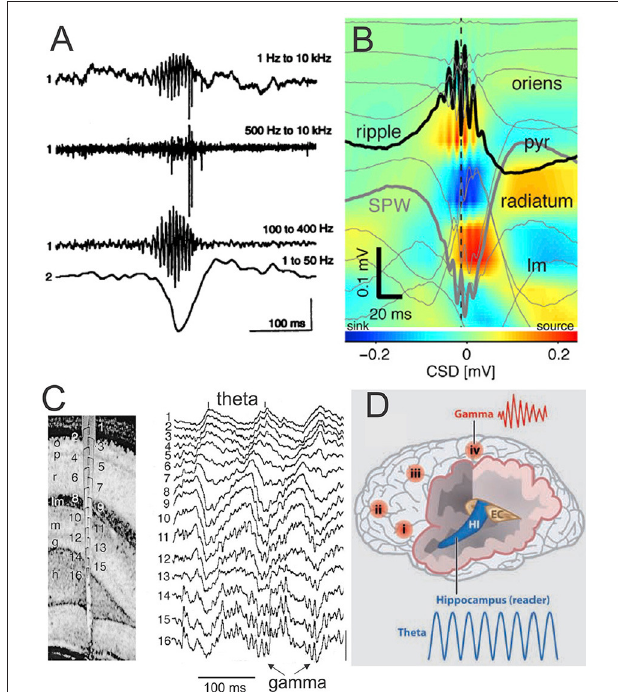
FIGURE 4 | SPW-R is composed by a large and sharp amplitude depolarization (SPW) of about 40-100 ms recorded in the hippocampus CA1 stratum radiatum and most often associated by brief and fast LFP oscillation ( ∼ 110–200 Hz) known as “ripples” (R) in the CA1 pyramidal layer. The SPW-R represents one of the most synchronous network patterns implicating synchronicity of 10–20% of hippocampus neurons ( Chrobak and Buzsáki, 1994 ). (A) Fast field oscillation in the CA1 region of the dorsal hippocampus. Simultaneous recordings from the CA1 pyramidal layer [electrode 1, wide-band recording (1 Hz–10 kHz)] and stratum radiatum (electrode 2, unit activity 500 Hz–10 kHz and fast field oscillation (100–400 Hz). The second and third traces are digitally filtered derivatives of the wide-band trace (1). Note simultaneous occurrence of fast field oscillations, unit discharges, and sharp amplitude depolarization (electrode 2). Calibrations: 0.5 mV (trace 1), 0.25 mV (traces 2 and 3), and 1.0 mV (trace 4) (from Buzsáki et al., 1992 , with permission). (B) Depth profile of averaged sharp-wave ripples (SPW-R) in a freely moving mouse ( n = 961 events; vertical site separation: 100 mm). Voltage traces (light gray) are superimposed on current-source density (CSD) map. Black trace: site of maximum amplitude ripple; heavy gray trace: site of maximum amplitude SPW (adapted from Stark et al., 2014, with permission). (C) Depth Profile of theta and gamma oscillations in the rat recorded during exploration (left) with a 16-site silicon probe introduced in the CA1-dentate gyrus axis. Numbers indicate recording sites (100 µ m spacing). Note the gradual shift of theta phase from str. oriens to str. lacunosum-moleculare (right) and the emergence of gamma waves superimposed on theta oscillation mainly in the granule cell layer and the hilus. Vertical bar: 1 mV (from Bragin et al., 1995, with permission). (D) Schematic representation of the brain showing location of γ oscillations in different cortical areas (i–iv) and 2 oscillation in the hippocampus (HI) entorhinal cortex